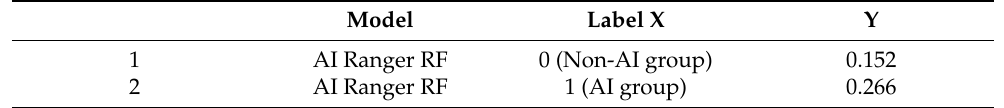
Table 3. Results of differences in social adaptability between AI group and non-AI group.